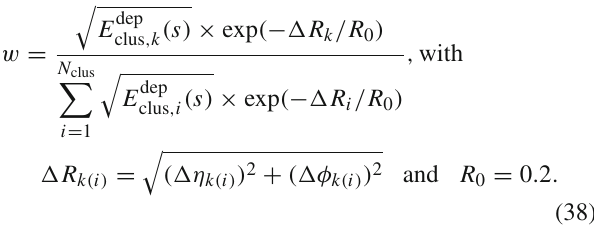
The choice of s depends on the dead material regions indi- cated in Fig. 17. The distances (cid:9)η and (cid:9)φ are measured between the topo-cluster direction and the dead material cell direction. The normalisation of w is calculated using all N